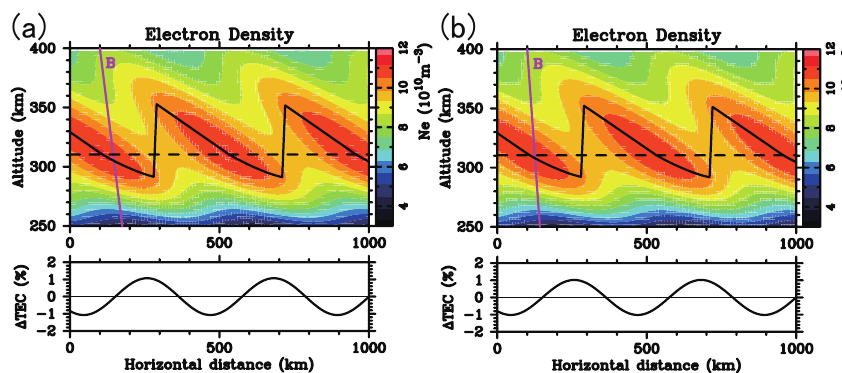
Fig. 5. Model calculations of the plasma density perturbations caused by a gravity wave at dip angles of (a) 63.5 ◦ and (b) 74.2 ◦ , respectively. The gravity wave is assumed to propagate southeastward (azimuth of 135 ◦ from the north) with a horizontal wavelength of 300km and a period of 40min, with a neutral wind oscillation amplitude of 7.0ms − 1 . The color scale, black solid line, and black dashed line in the top panel indicate the plasma density, peak altitude of the electron density, and original peak altitude without the perturbations, respectively. The purple line indicates the dip angle of the magnetic field. The bottom panel shows the amplitude of TEC perturbations as a percentage of the background value. TEC is obtained from integration of the plasma density from 250 to 400km in altitude.